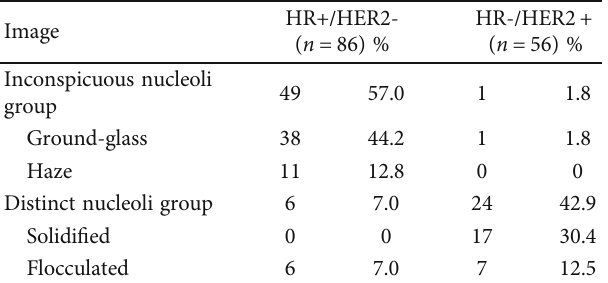
Table 4: Special images of nuclear